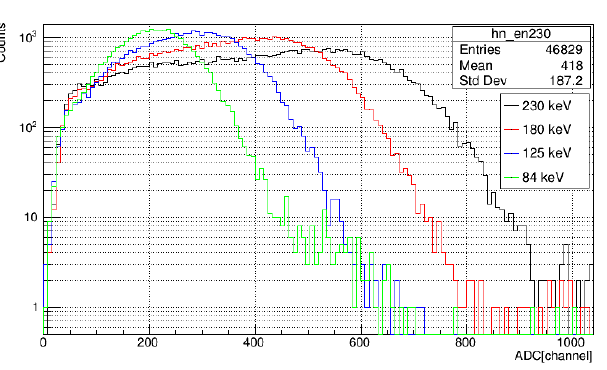
Figure 8 Time of flight distributions for the